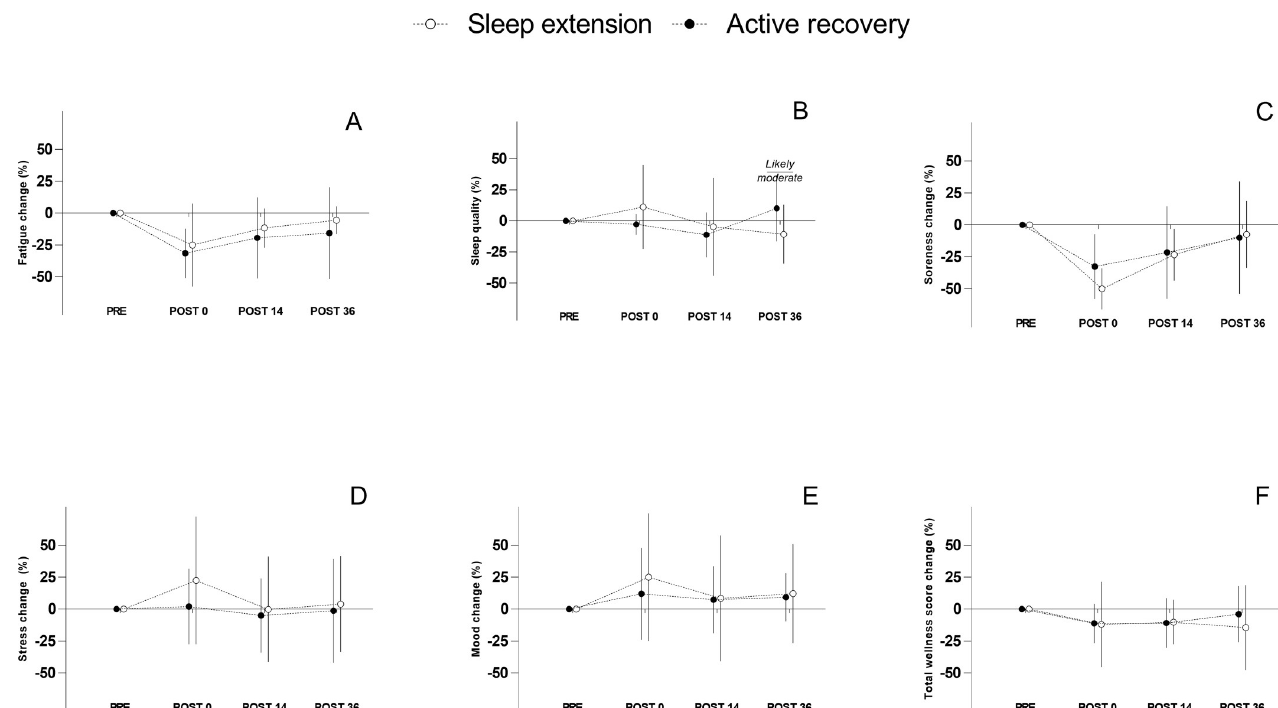
Fig 4. Between group comparison for wellness scores. White and black dots represent the sleep extension and active recovery group respectively. Error bars represent standard deviations. Figure A: Fatigue. Figure B: Sleep quality. Figure C: Soreness. Figure D: Stress. Figure E: Mood. Figure F: Total wellness score.